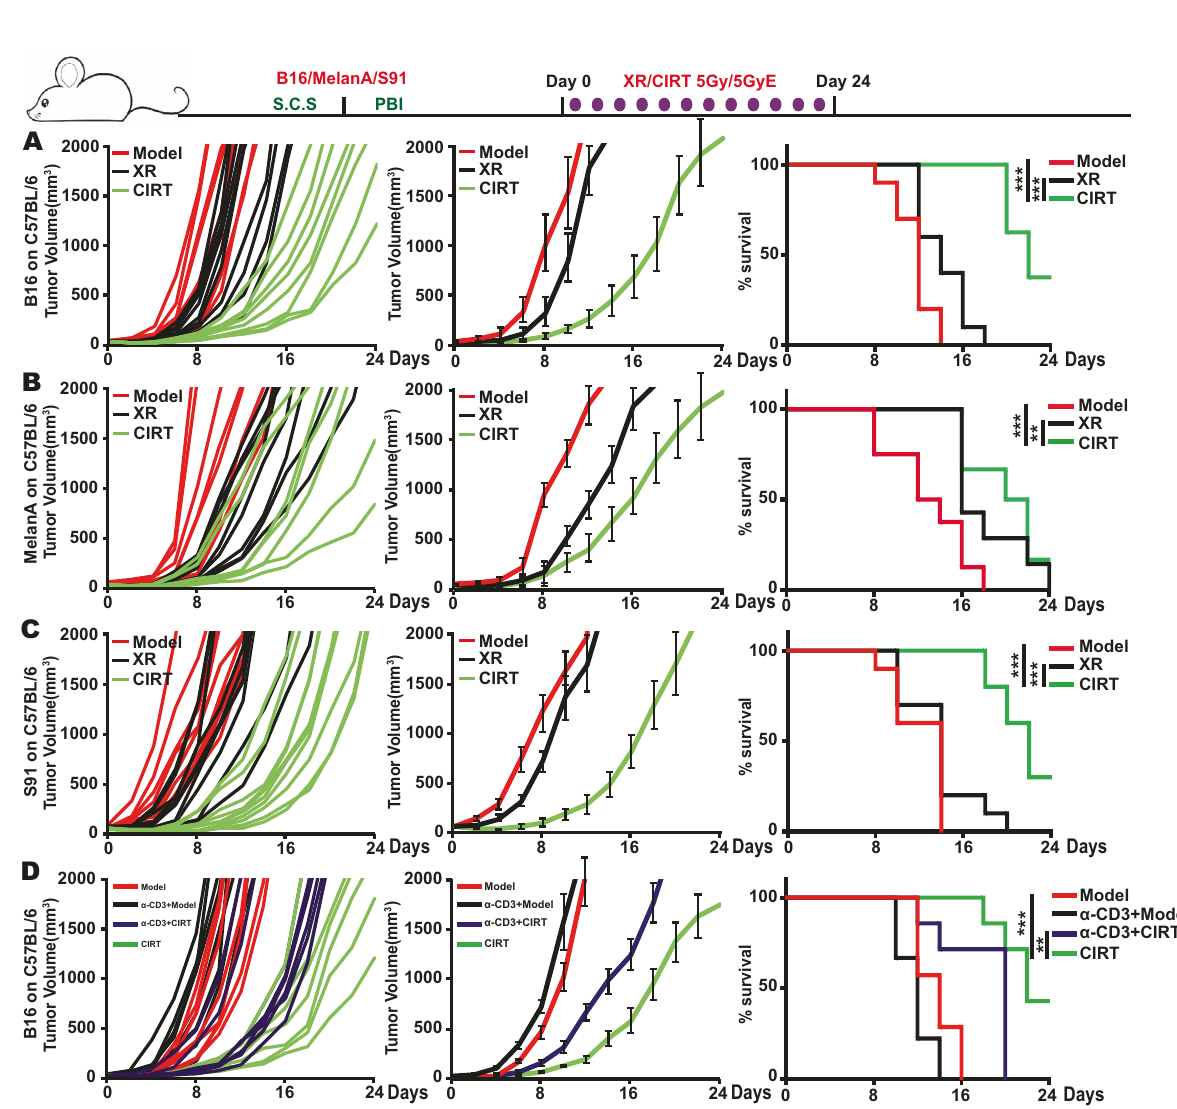
Fig. 5 Carbon ion radiotherapy decreased tumour growth and increased overall survival. The C57BL/6 mice bearing subcutaneous B16, MelanA and S91 melanoma (model) were locally irradiated with a physical dose of 5 Gy X-ray (XR) or 5 GyE carbon ions (CIRT) on the tumour site. The tumour volume of the mice was measured every 2 nd day from the day of radiation until the tumour volume reached 2000 mm 3 . The carbon ion radiotherapy prolonged the survival time of tumour-bearing mice and slowed down the growth rate of tumours A – C . CD3 T cell- depleted littermates bearing subcutaneous B16 melanoma were locally irradiated with physical dose of 5 Gy X-ray (XR) or 5 GyE carbon ions (CIRT) on the tumour site. The tumour growth in the CD3-depleted mice was faster than in an immunocompetent group, the carbon ion radiation decreased the overall survival though promoting immune response D . Representative images and quanti fi cations are shown (mean ± SD of triplicate assessments, Student ’ s t -test, *** p < 0.001). CSF, IL-6, TGF- β and VEGF in the serum of post-radiation mice, levels of JAK2 and STAT3 while the expression of anti-apoptotic Bcl-2 was reduced and the caspase activity was increased which might be explained why the percentage and number of MDSC decreased. Moreover, we observed a signi fi cant decrease in GM-